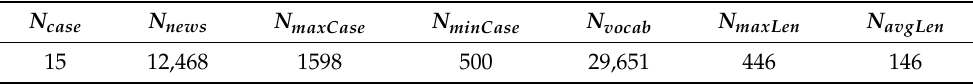
Table 1. Data statistics for our Dataset. Where N case is the number of the cases, N news is the number of the news, N maxCase is the maximum number of news in the same case, N minCase is the minimum number of news in the same case, N vocab is the size of vocabulary, N maxLen is the maximum length of news and N avgLen is the average length. N case N news N maxCase N minCase N vocab N maxLen N